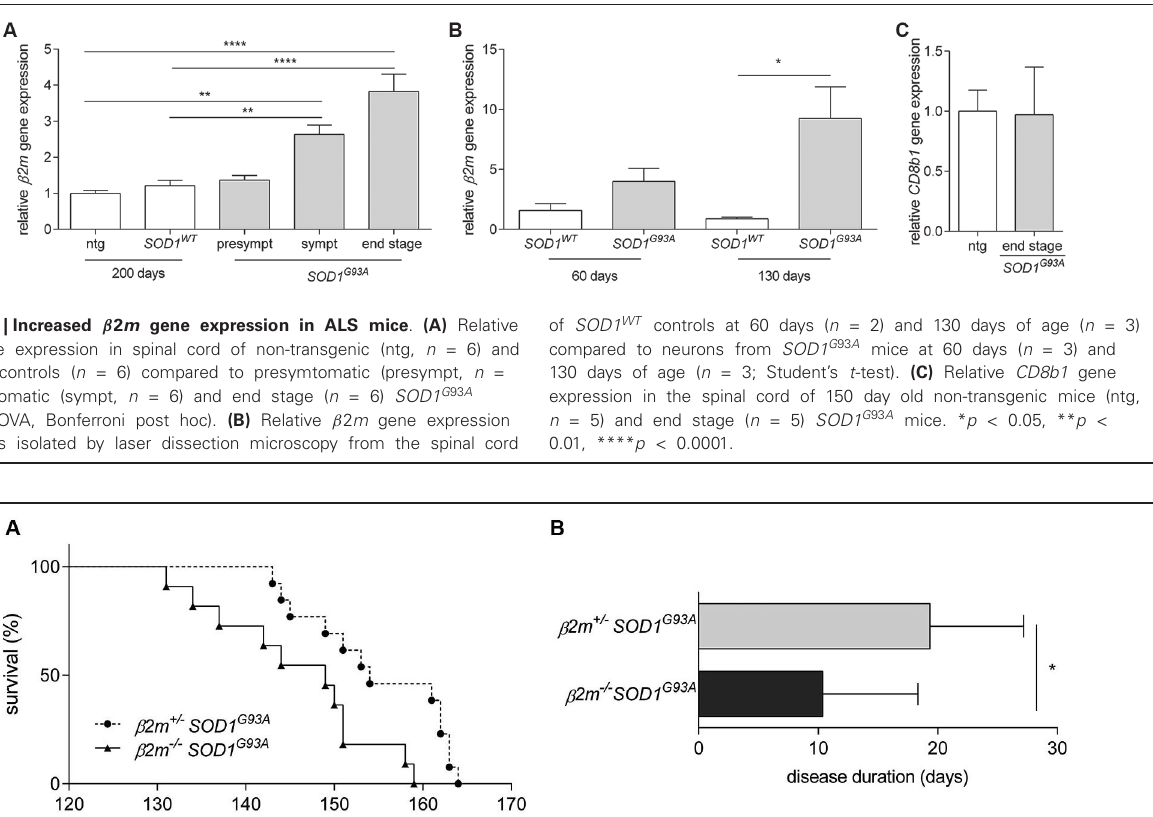
FIGURE 2 | Decreased survival in β 2 m knockout ALS mice . (A) Survival analysis of β 2 m + / − SOD1 G 93 A ( n = 13, 154.9 ± 7.7 days) and β 2 m − / − SOD1 G 93 A mice ( n = 11, 146.0 ± 8.8 days; Log-Rank p = 0.009). (B) Disease duration of β 2 m + / − SOD1 G 93 A ( n = 9) and β 2 m − / − SOD1 G 93 A mice ( n = 8). * p <